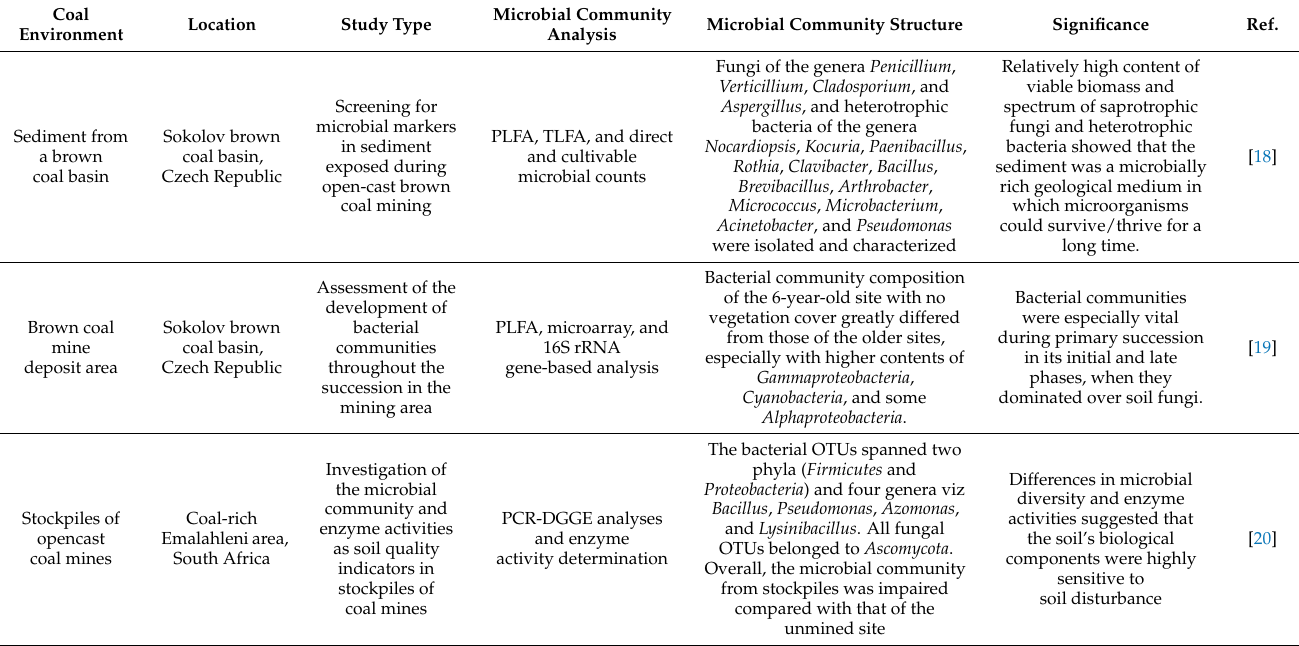
Table 1. The use of traditional techniques and the development of novel approaches have advanced the knowledge of the microbial community composition and structure residing in coal-associated environments